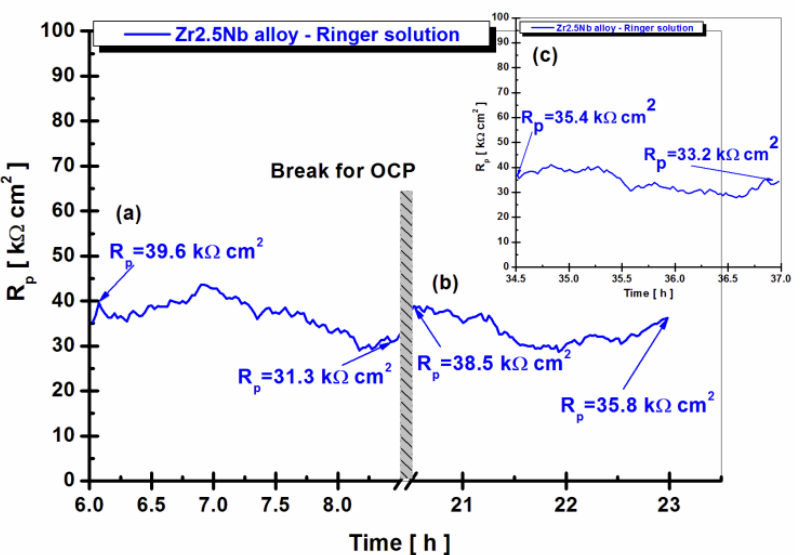
Figure 4. Evolution of the polarization resistance of the Zr2.5Nb alloy in Ringer’s solution: ( a ) the polarization resistance segment (Rp 1 ), ( b ) the polarization resistance segment (Rp 2 ), and ( c ) the polarization resistance segment (Rp 3 ).